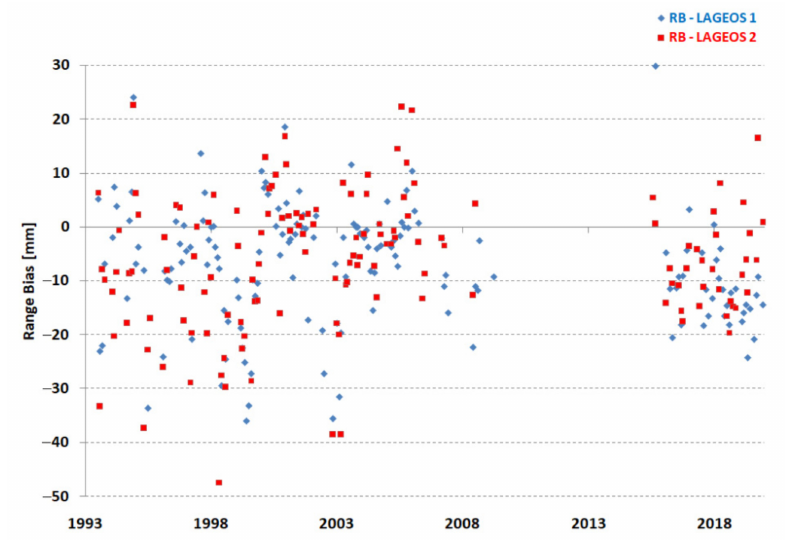
Figure 6. Borowiec SLR station—monthly range bias of satellites LAGEOS-1 and